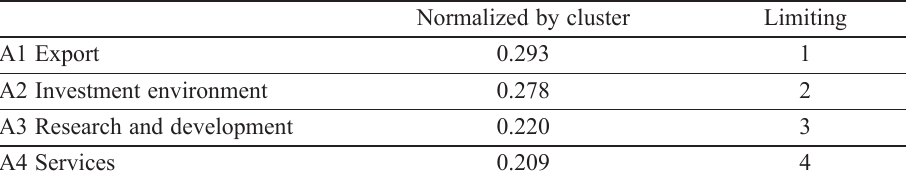
Table 14. Prioritization of the alternatives under the risk sub-network